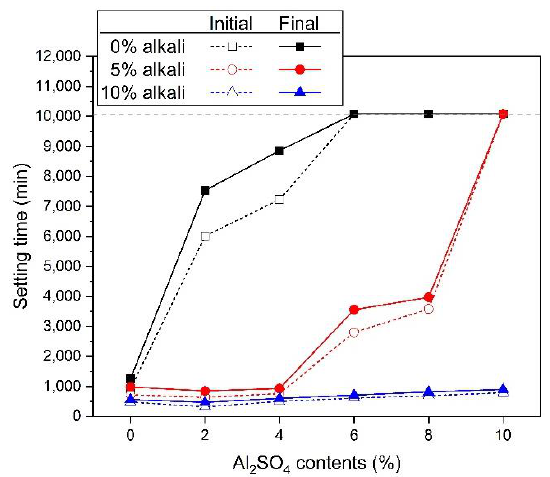
Figure 1. Setting time of each mixture.